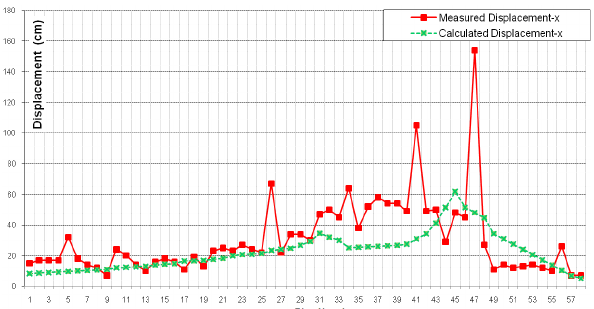
Figure 12: Comparison of the measured and calculated peak displacements of the viaduct Fig. 12. Comparison of the measured and calculated peak piers in the x direction caused by the Düzce earthquake displacements of the viaduct piers in the x-direction caused by the In Figure 13 a pattern similar to that shown in Figure 12 can be observed. The viaduct piers D¨uzce earthquake. close to the fault line responded more than the others. The calculated values do not change dramatically, but the measured values do. This is because the parameters taken into account in the analysis are limited to the material parameters, dimensions and height of the viaduct piers, the distance of pier location to fault line, ground motion parameters which are why it cannot perfectly reflect the real case. However, especially in the y direction, the calculated values are not too very different from the measured values. These considerably logical results are obtained from the numerical analysis which is compared to the results obtained from the geodetic method.